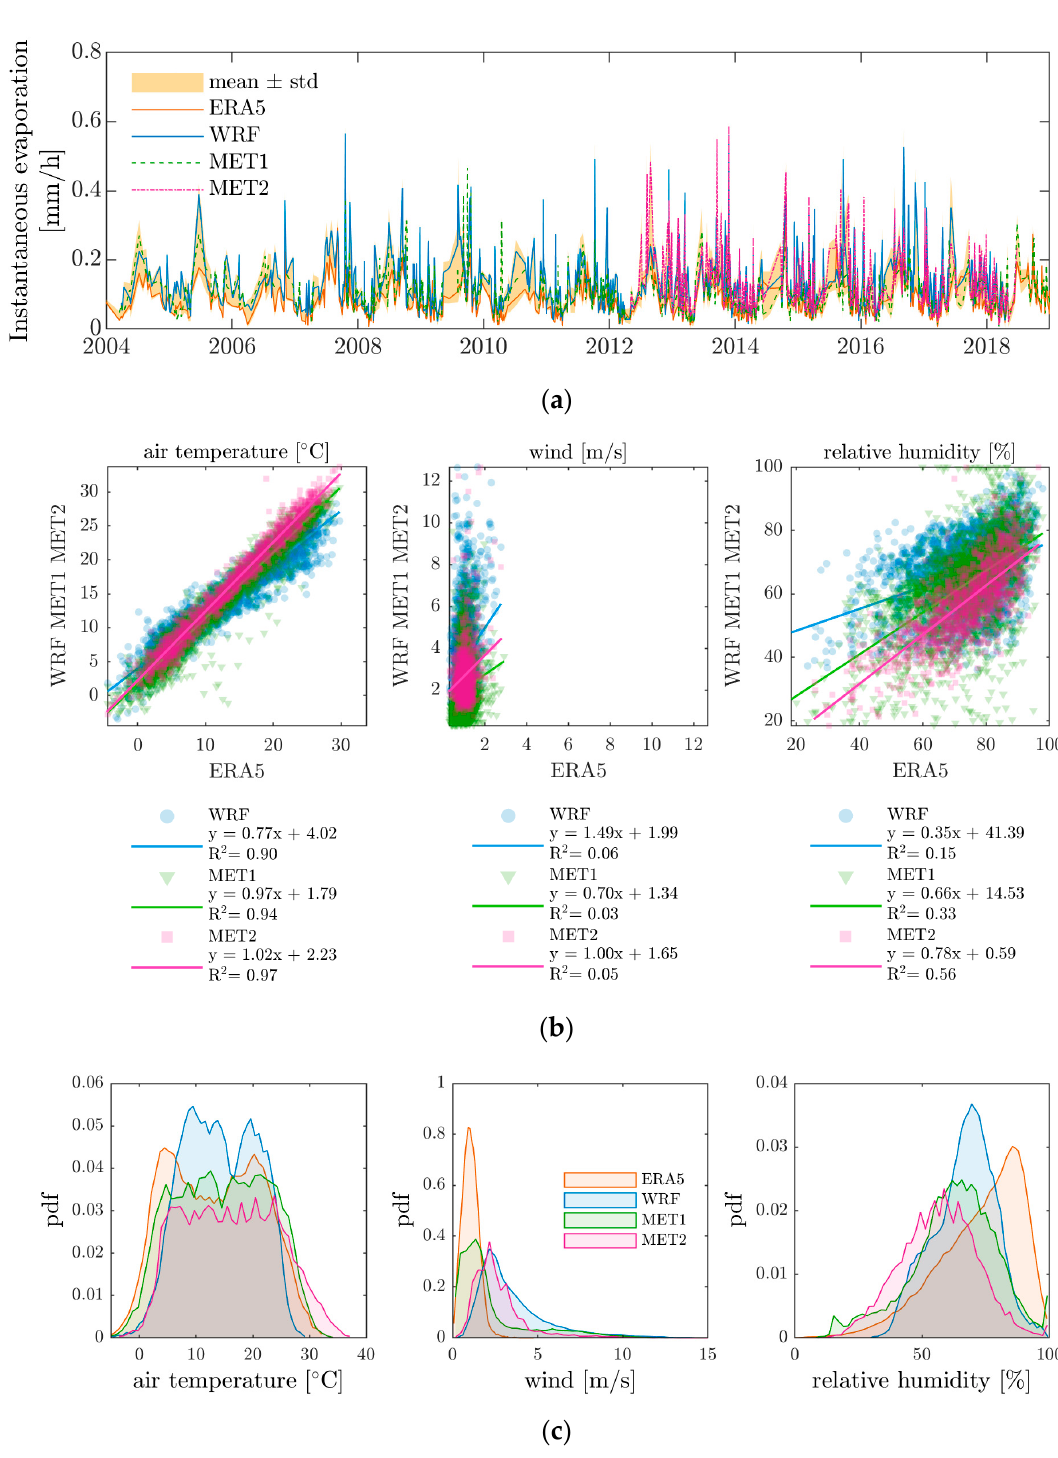
Figure 6. ( a ) Instantaneous evaporation ( E h ) from Lake Garda estimated with LakeVap using CCI- Lakes dataset and different meteorological data sources. Lines depict the spatial average of E h maps obtained with meteo variables from ERA5 (orange continuous line), WRF (blue continuous line), and in-situ observations at MET1 (dashed green line) and MET2 (dotted magenta line) weather stations (see Figure 3b for the location of MET1 and MET2). The light-yellow shaded area represents the range of variation of E h due to different meteorological sources. ( b ) Scatterplots of air temperature, wind, and relative humidity as obtained from WRF (averaged over the lake surface), MET1, and MET2 in-situ data against ERA5 (averaged over the lake surface); ( c ) probability distribution of air temperature, wind, and relative humidity from the four